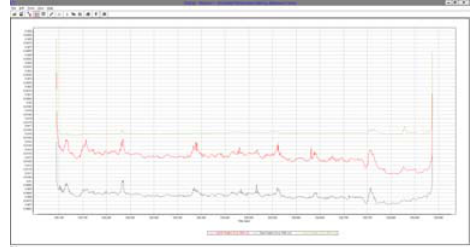
Figure 6: POSPac UAV trajectory RMS estimate – Railway Corridor